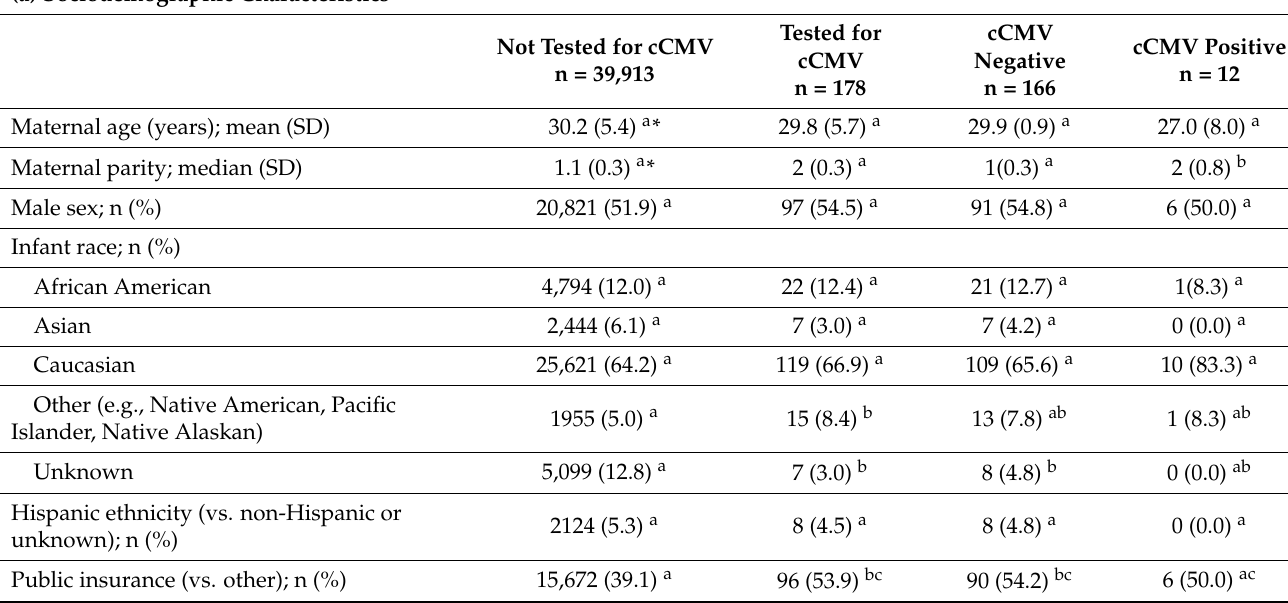
Table 1. ( a , b ) Characteristics of infants tested for congenital cytomegalovirus at a quaternary chil- dren’s hospital from 2014 to 2019 (N =